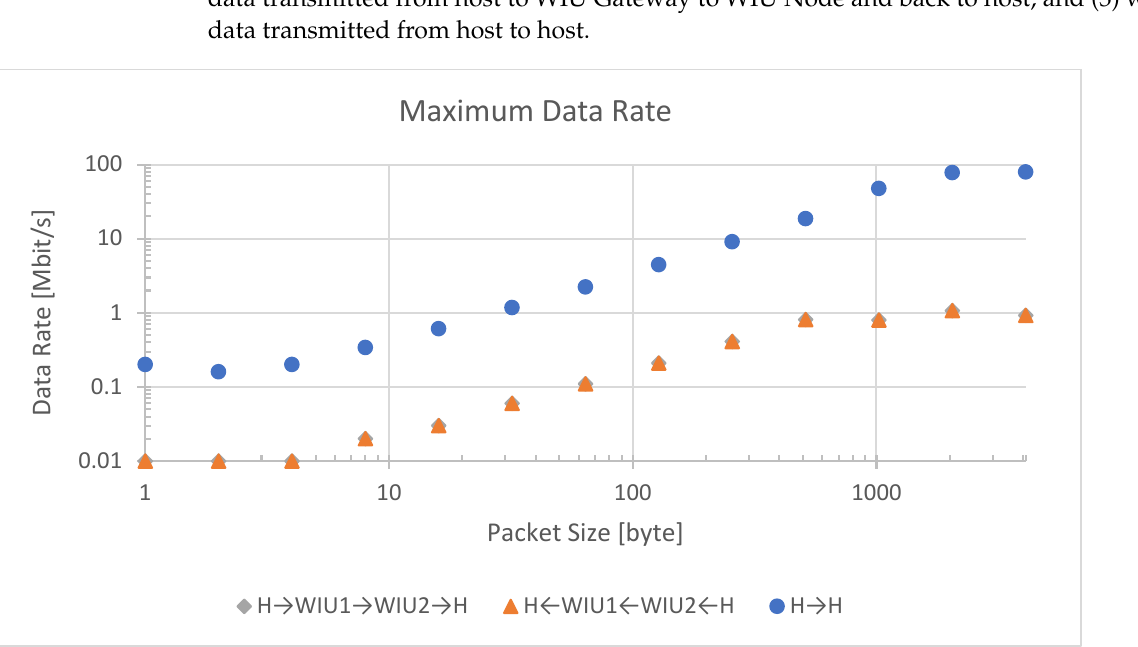
Figure 7. Maximum data rate for packages from 1 to 4096 bytes.